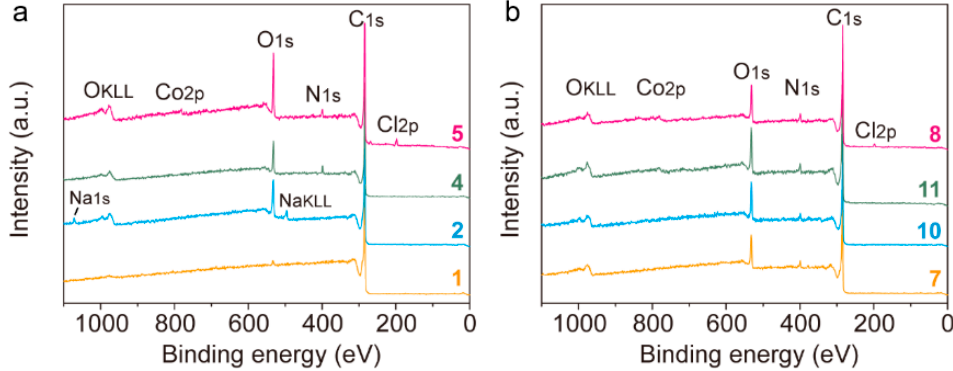
Figure 2. Survey XPS spectra of ( a ) CB (1), oxidized CB (2), CB-phen (4), CB-phen-Co (5) and ( b ) CB-pda (7), CB-salophen (10), CB-salophen-Co (11) and CB-pda-Co. The number of each spectrum refers to the sample with the structure shown in Scheme 1.